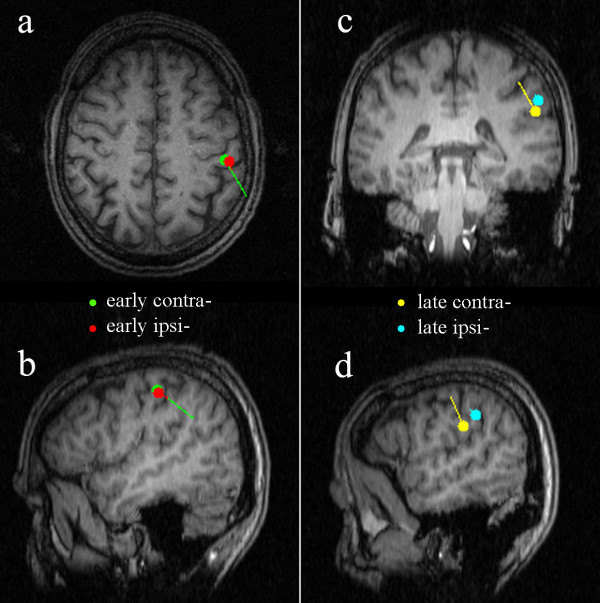
Source localizations of responses to index finger stimulation alone. Identified dipole sources of responses in the right hemisphere shown in Figure 1 are superimposed on this subject's MRI. The left horizontal (a) and sagittal (b) slices show the locations of early contralateral response (green dot in right anterior parietal field) to LD2 stimulation and early ipsilateral response (red dot) to RD2 stimulation. The coronal (c) and sagittal (d) slices in the right column show the locations of the late contralateral response (yellow dot in right S2) to LD2 stimulation and late ipsilateral response (cyan dot) to RD2 stimulation. The tails of those dots indicate dipoles' strength and direction.